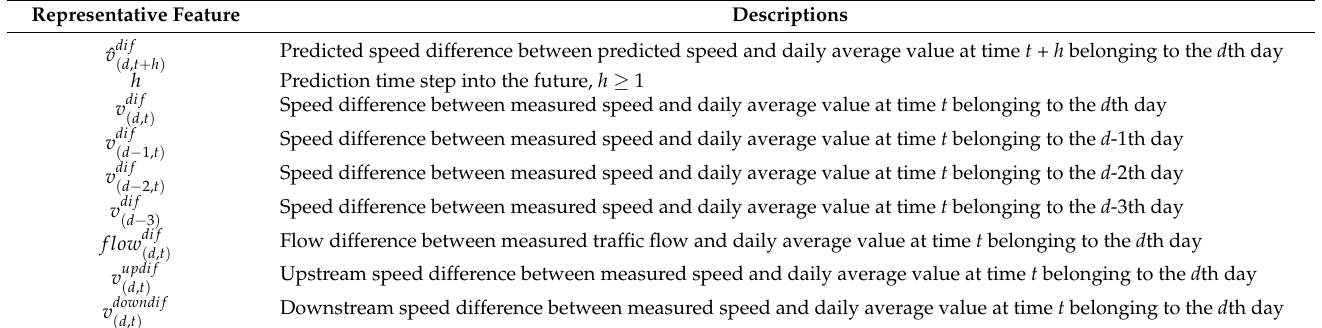
Table 4. Input candidates of the proposed prediction model in this study.